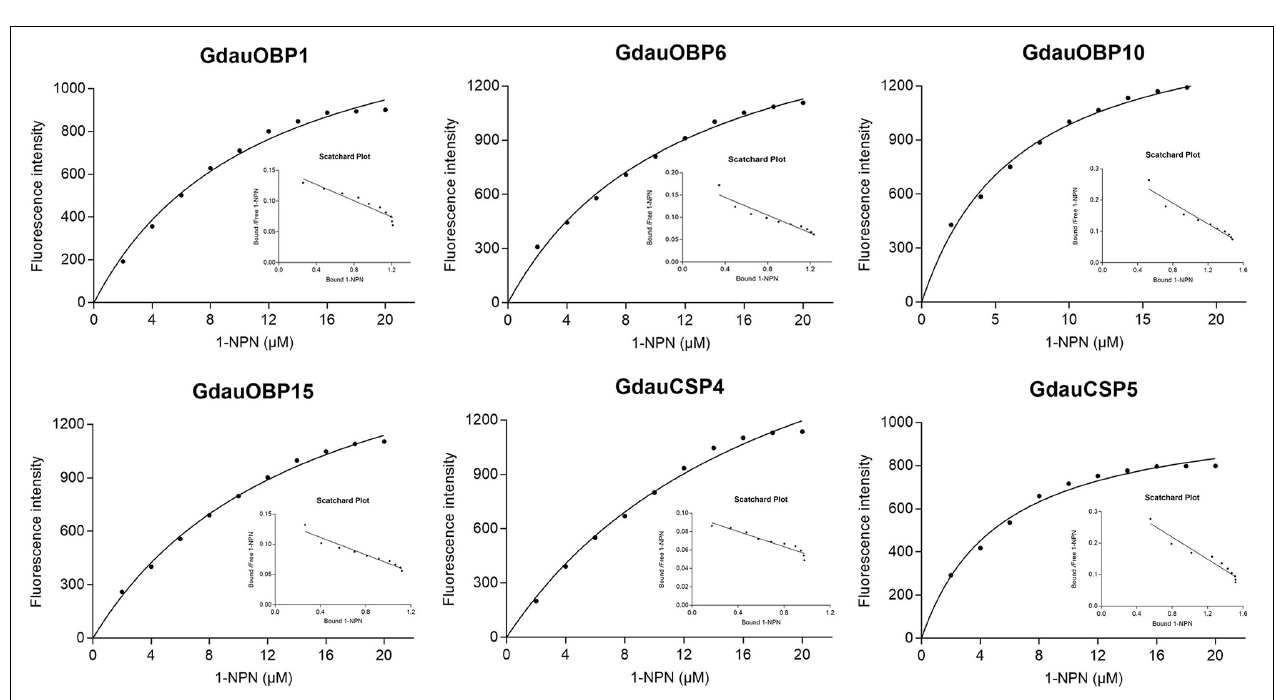
FIGURE 3 | Binding curves and Scatchard plot analysis of 1-NPN to GdauOBP1, GdauOBP6, GdauOBP10, GdauOBP15, GdauCSP4, and GdauCSP5 at pH 7.4.